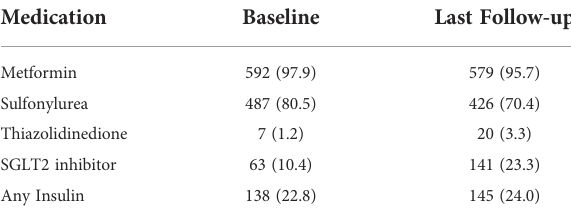
TABLE 3 Use of concomitant anti-diabetic medication with dulaglutide at baseline and last